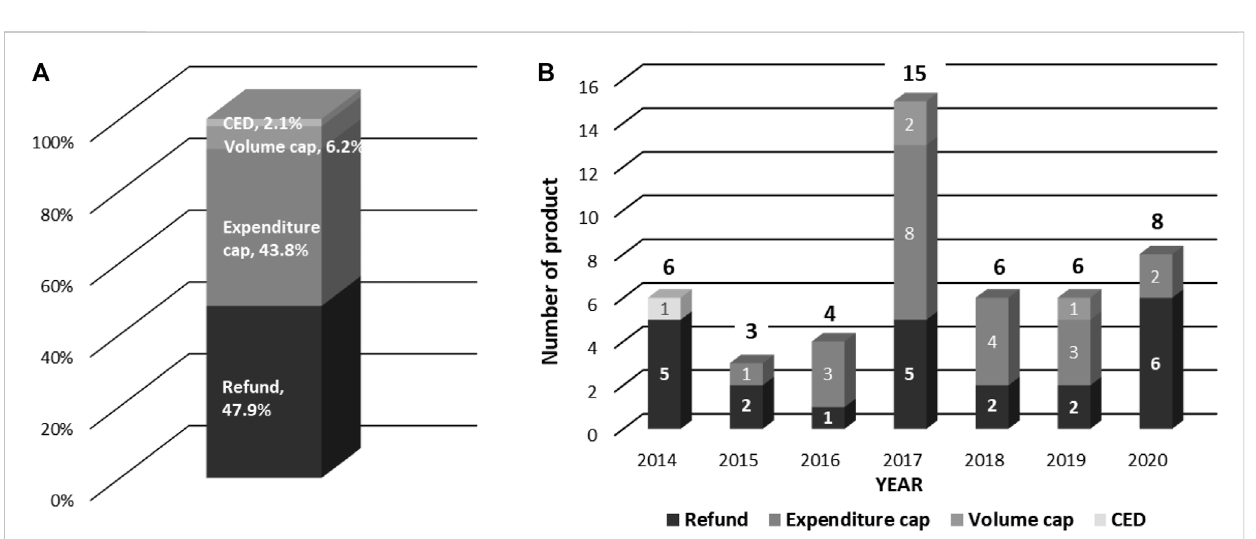
FIGURE 3 Types of MEAs and Number of products by year. (A) Types of MEAs (B) Yearly Number of Products contracted with